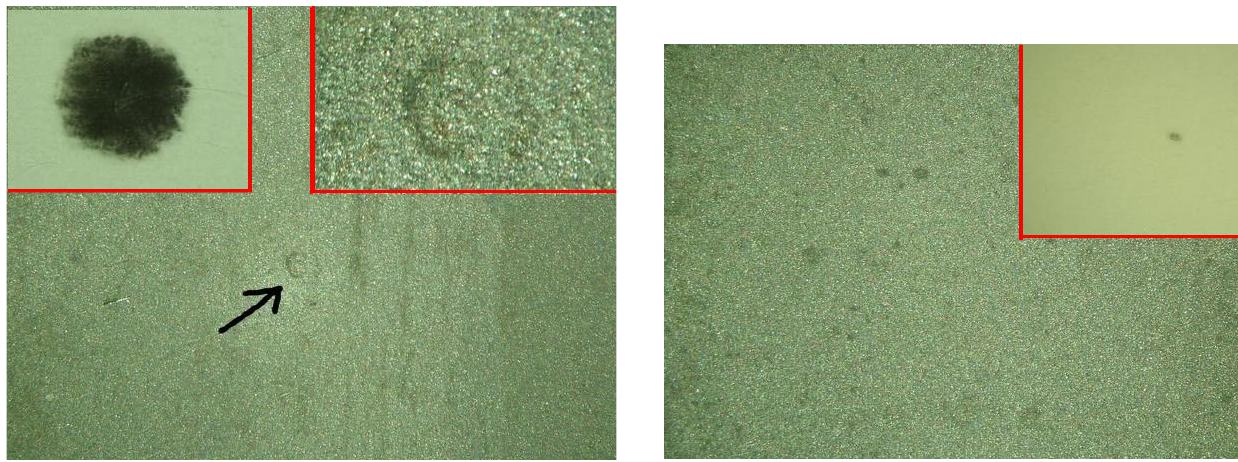
FIG. 8. (Color) Downstream surface of the target dosed with the ILC1 mode (target 3). The horizontal size of this picture corre- sponds to 10 mm. There is an unclear colored spot that can be identified as the beam trace because a very tiny black point was observed at the same position on the thermal paper, as shown in the right-upper corner. In the developing paper, a clear black spot was